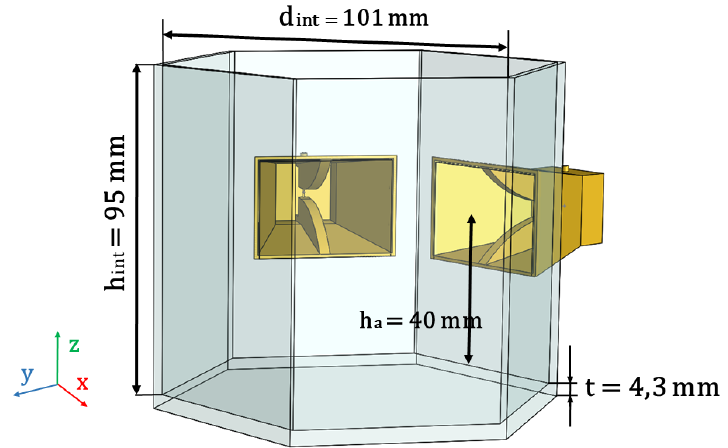
= 0), from a non-operational state LD